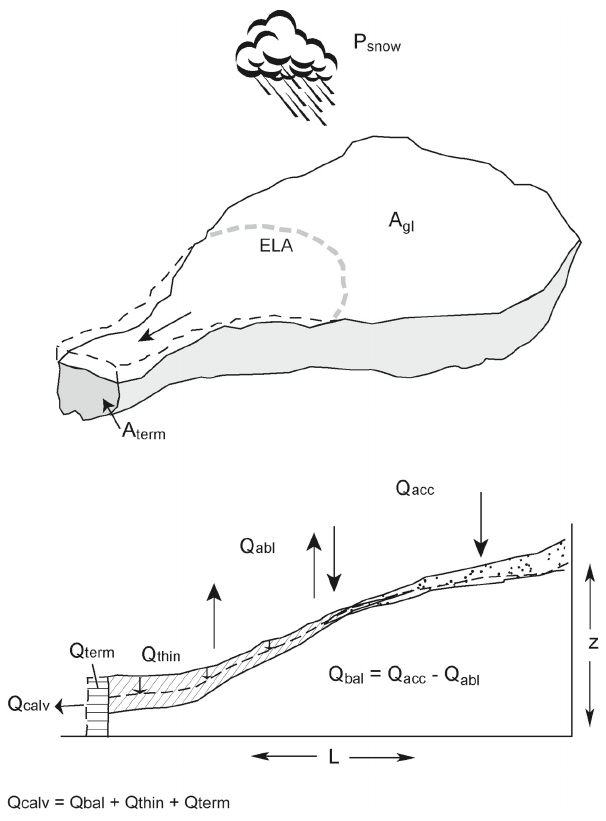
Fig. 10. Illustration of fluxes and areas relevant for estimating the mass budget of calving